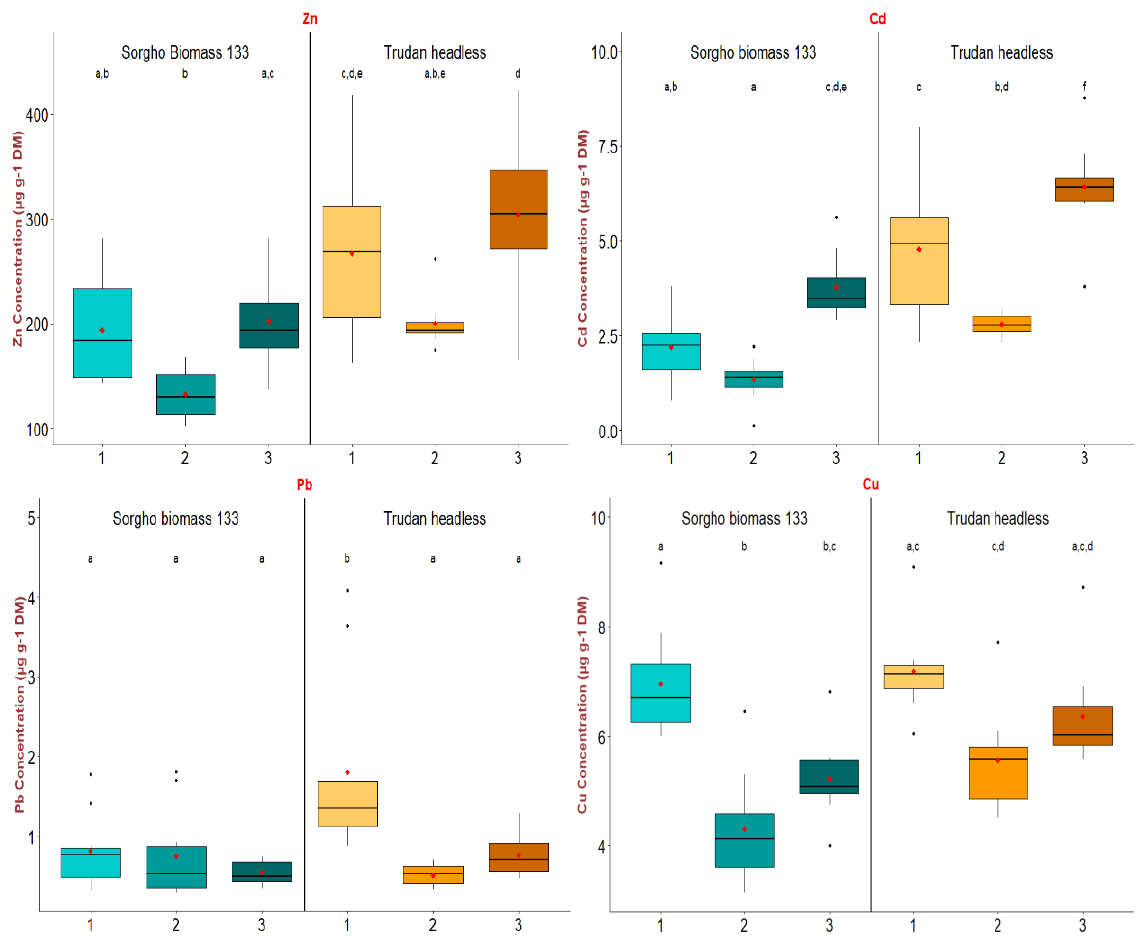
Figure 3. Concentrations of Zn, Cd, Pb, and Cu in the sorghum Biomass 133 (blue) and the sorghum Trudan Headless (orange) in the three areas (1 = area 1, 2 = area 2, 3 = area 3). The box plots indicate the median and the 25 and 75 percentiles; red diamond = mean. Significant differences between conditions are indicated by different letters at the level of α = 0.05.